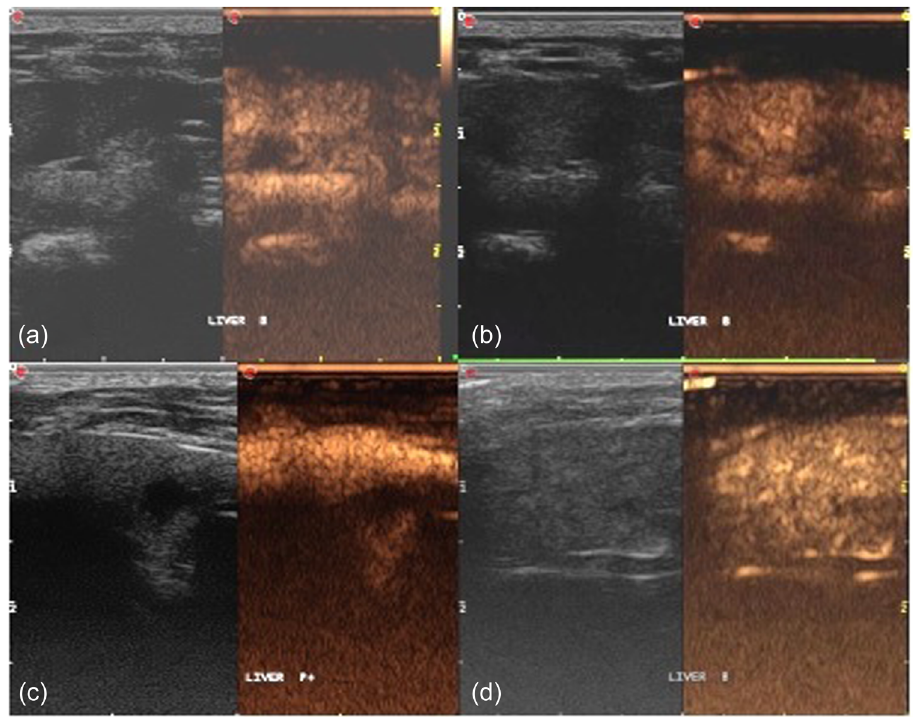
Figure 5: Hepatic ultrasonography in rats: ( a ) BCMs, ( b ) TBCMs, ( c ) TBCMs carrying the bFGFp, and ( d ) SonoVue microbubbles.